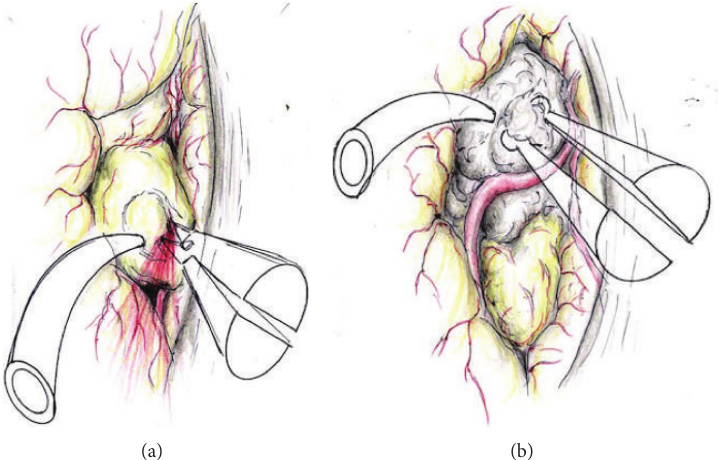
Figure 2: Schema of intraoperative findings. (a) Incision of the initially yellowish tumor (lipoma component) results in projectile bleeding. (b) The grayish tumor is exposed just behind the A3. Residual lipoma is observed